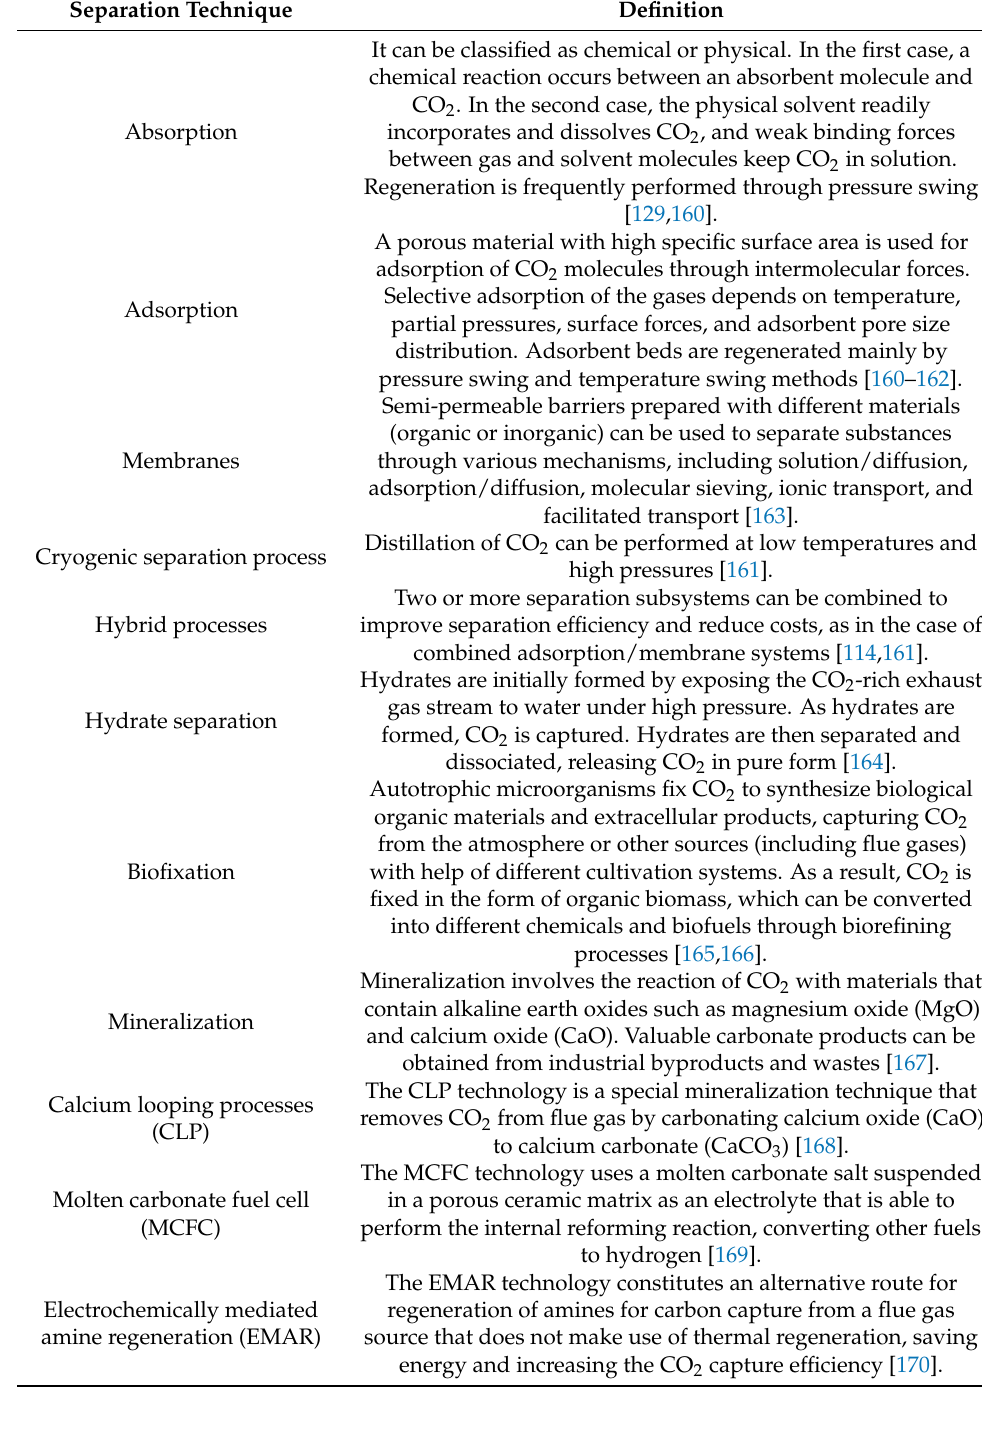
Table 11. Most relevant CO 2 purification